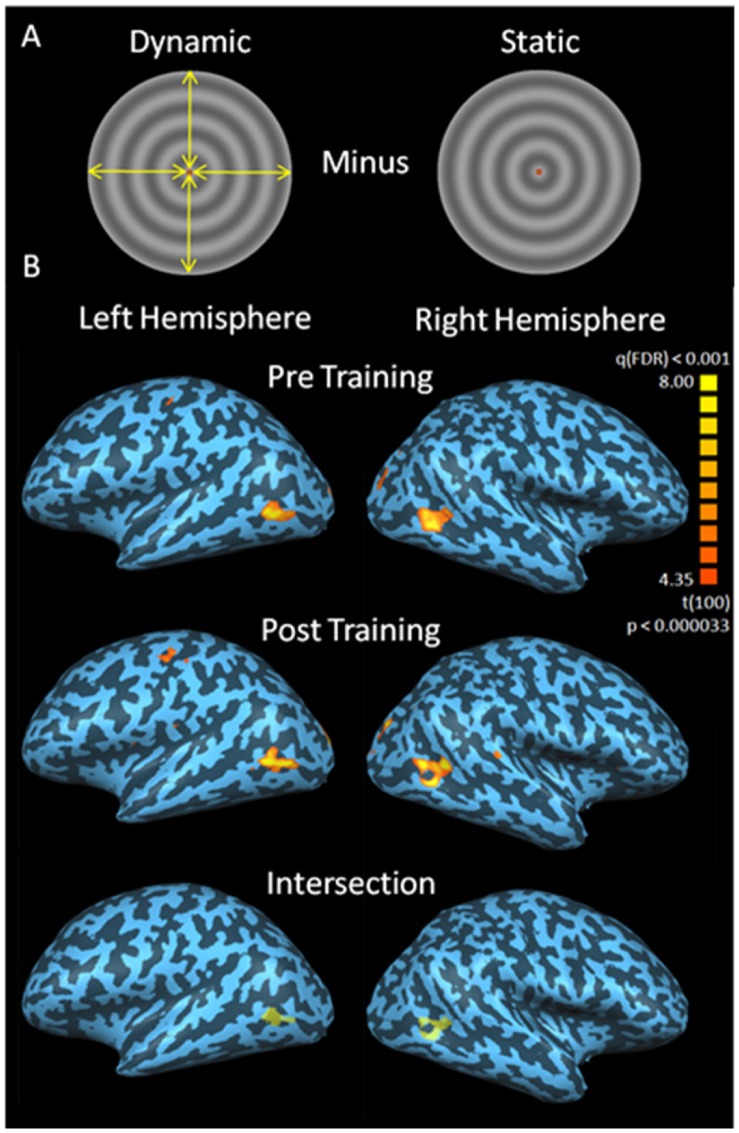
Localization of hMT+.The hMT+ localization stimulus is shown in panel A with yellow arrows representing the centripetal oscillations that occurred during the dynamic phase. Example localization results for one participant are shown in panel B. hMT+ localization data were acquired pre (top row) and post (middle row) training. The hMT+ ROI used for analysis was derived from the intersection of the pre and post training ROIs (bottom row). The FDR corrected (q<0.001) statistical maps are rendered on inflated representations of the participant’s left and right cerebral hemispheres.